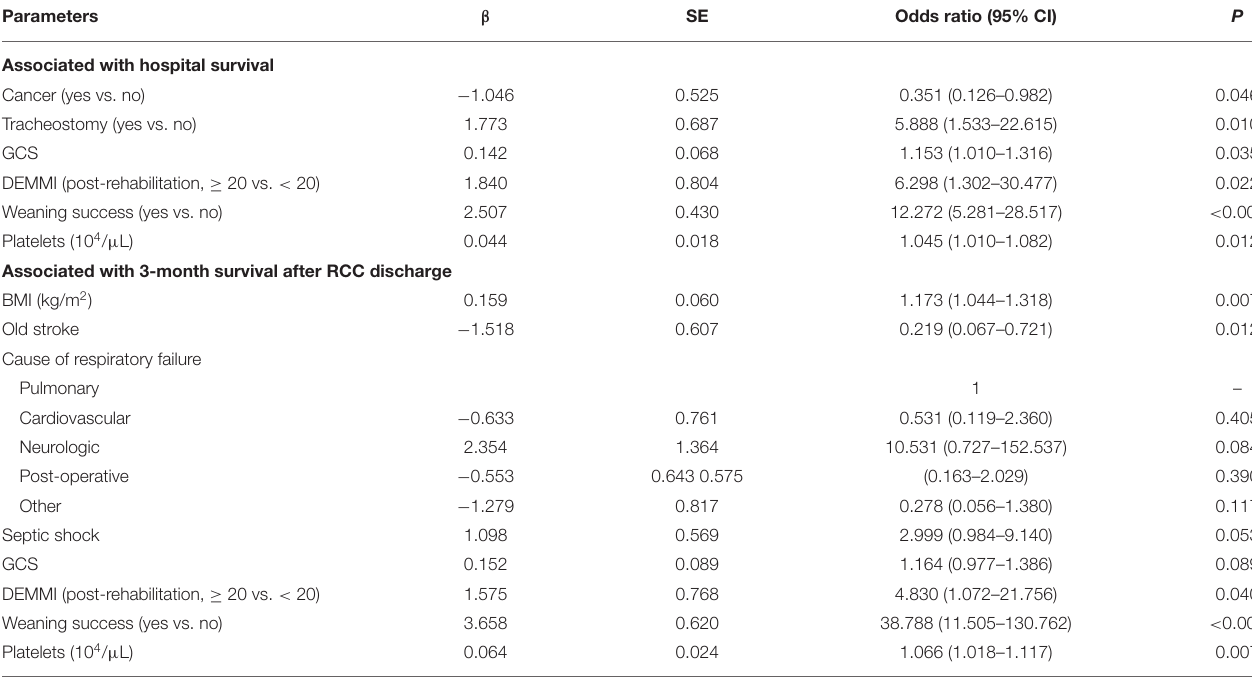
TABLE 4 | Multivariate logistic regression models for significant clinical characteristics associated with hospital survival and 3-month survival after RCC discharge*. Parameters